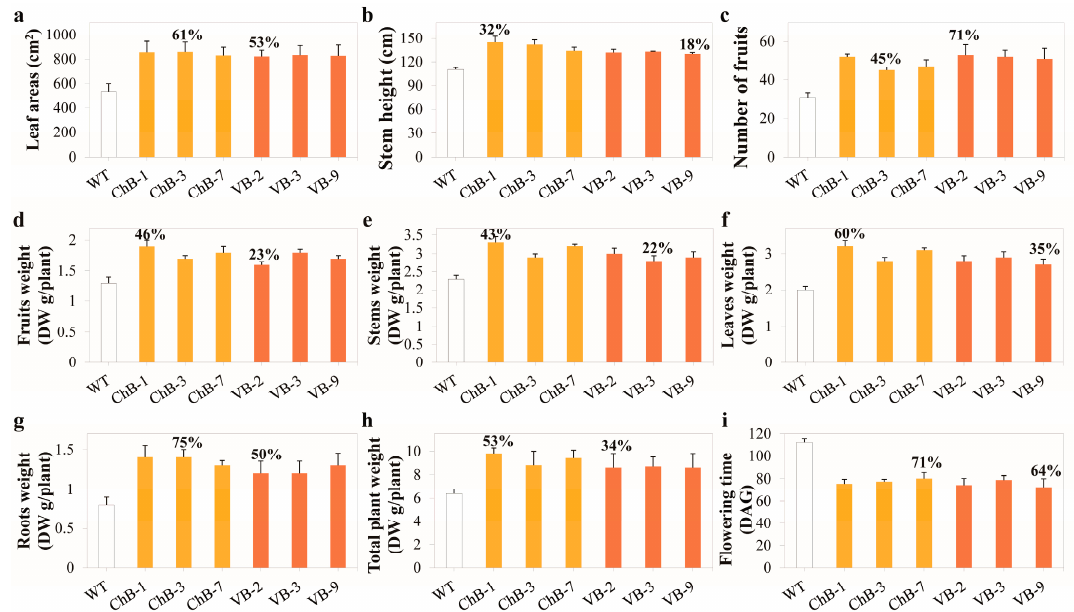
Figure 2. Phenotypic changes in the transgenic tobacco plants overexpressing T. maritima BglB targeted to the chloroplasts and vacuoles in comparison with those in the wild-type tobacco plants. ( a ) leaf areas; ( b ) stem height; ( c ) fruits numbers; ( d ) fruits weight; ( e ) stem weight; ( f ) leaves weight; ( g ) roots weight; ( h ) total plant weight; and ( i ) flowering time. Average values were calculated in triplicate ( n = 3) for each transgenic line and wild-type tobacco plants. The bars of each column show standard deviation (SD).